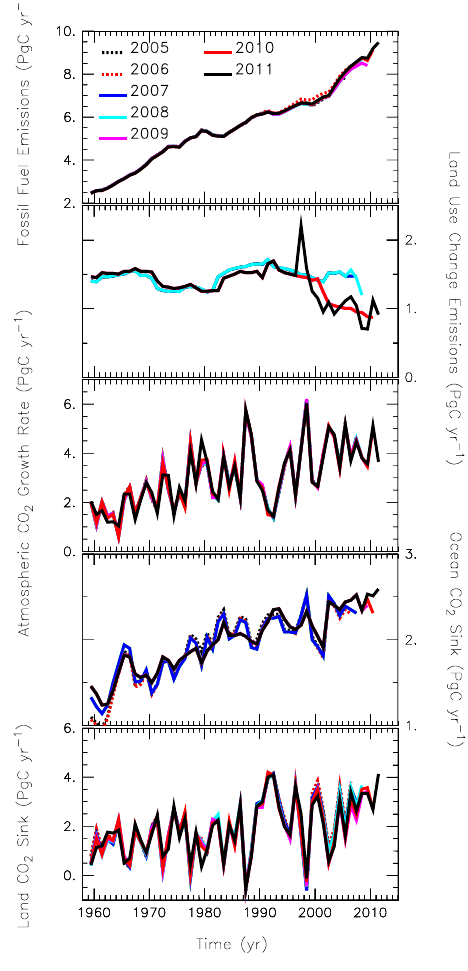
Fig. 6 4 Figure 6. Comparison of global carbon budget components re- leased annually by GCP since 2005. CO 2 emissions from both (a) fossil fuel combustion and cement production, and (b) land- use change, and their partitioning among (c) the atmosphere, (d) the ocean, and (e) the land. The di ff erent curves were pub- lished in (dashed black) Raupach et al. (2007), (dashed red) Canadell et al. (2007), (dark blue) online only, (light blue) Le Qu ´ er ´ e et al. (2009), (pink) Friedlingstein et al. (2010), (red) Peters et al. (2012a), and (black) this study. All values are in PgCyr − 1 .